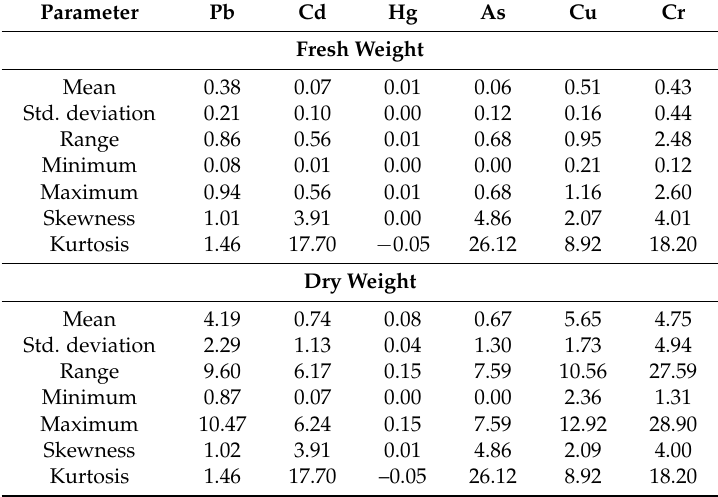
Table 4. Descriptive statistics of heavy metal concentrations (mg · kg − 1 ) in cabbages from the study area.